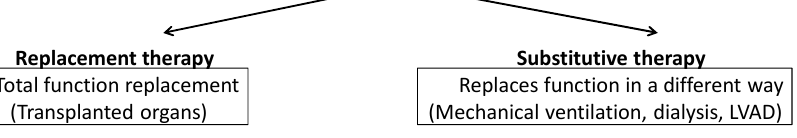
Figure 2. Modified from Sulmasy [60].